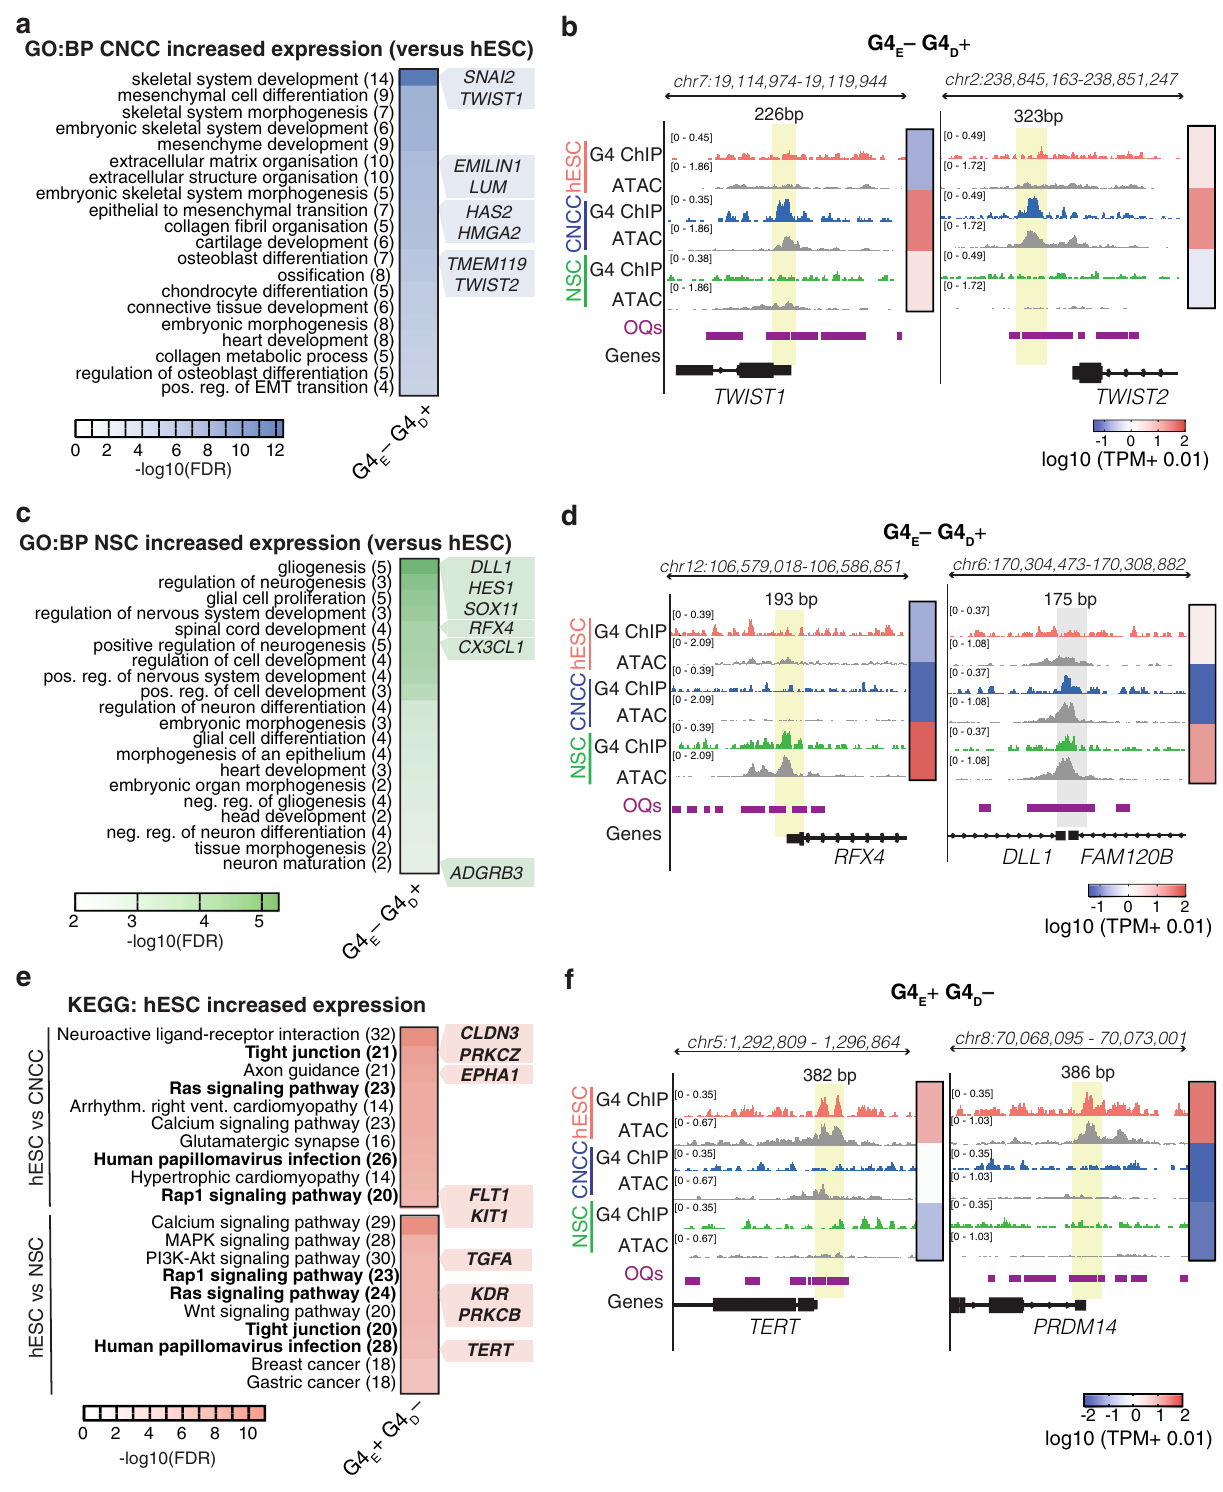
(Miltenyi Biotec) and data were analysed using FlowJo 10.5.3 (FlowJo